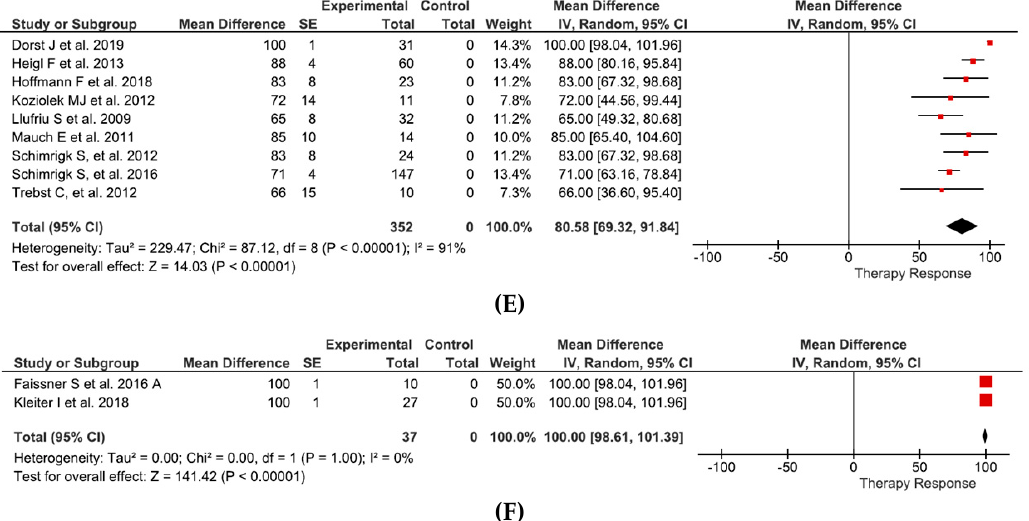
Figure 2. The 95% normal approximation confidence interval is provided in the meta-analyses. The given SE correspond to normal approximation confidence interval (sqrt( p (1- p )/ n )). ( A ) Effects of PE in RRMS and CIS. ( B ) Effects of PE in PMS. ( C ) Effects of PE in opticus neuritis. ( D ) Effects of PE in NMO. ( E ) Effects of IA in RRMS and CIS. ( F ) Effects of IA in NMO. RRMS = relapsing-remitting multiple sclerosis, CIS = clinically isolated syndrome, PMS = progressive multiple sclerosis, SE = standard error, IV = instrumental variables. Figure 2A: Correia et al. [51], Dorst et al. [42], Ehler et al. [49], Ehler at al. [43],